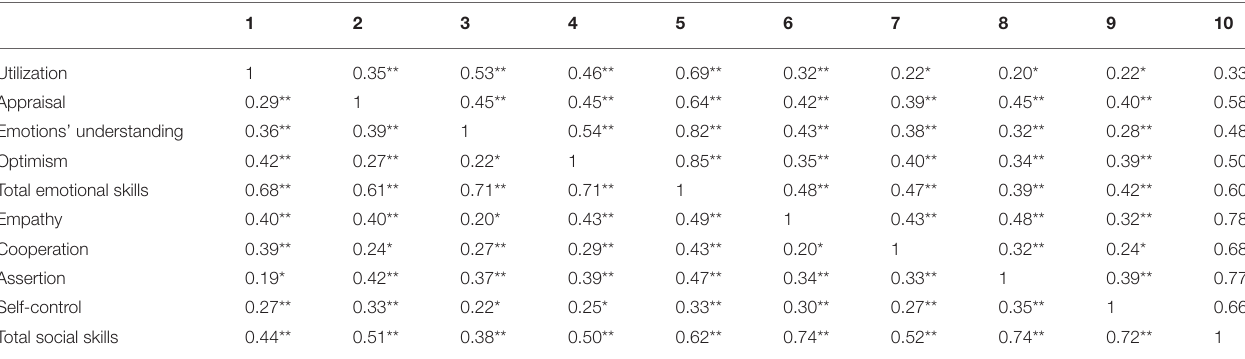
TABLE 3 | Correlations of dependent